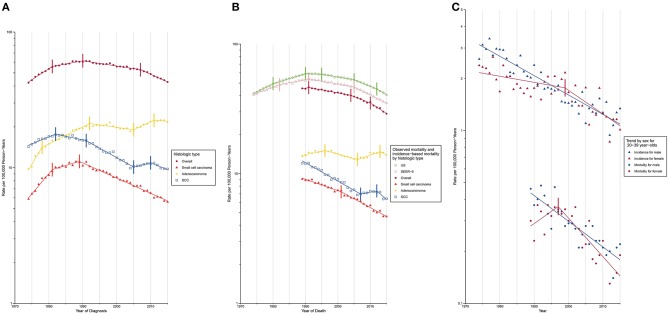
Trends in Annual Lung Cancer Incidence and Mortality Rates. SCC, squamous cell carcinoma. Data markers denote the observed incidence and mortality rates (cases per 100,000 person-years). The slope of the lines represents APC; vertical tics on these lines represent the joinpoints. Rates are age-adjusted to the 2,000 US standard population. (A) Overall lung cancer incidence and incidence by histologic type. (B) Overall lung cancer mortality and mortality by histologic type. (C) Overall lung cancer incidence and mortality among young adults aged 20–39 years.